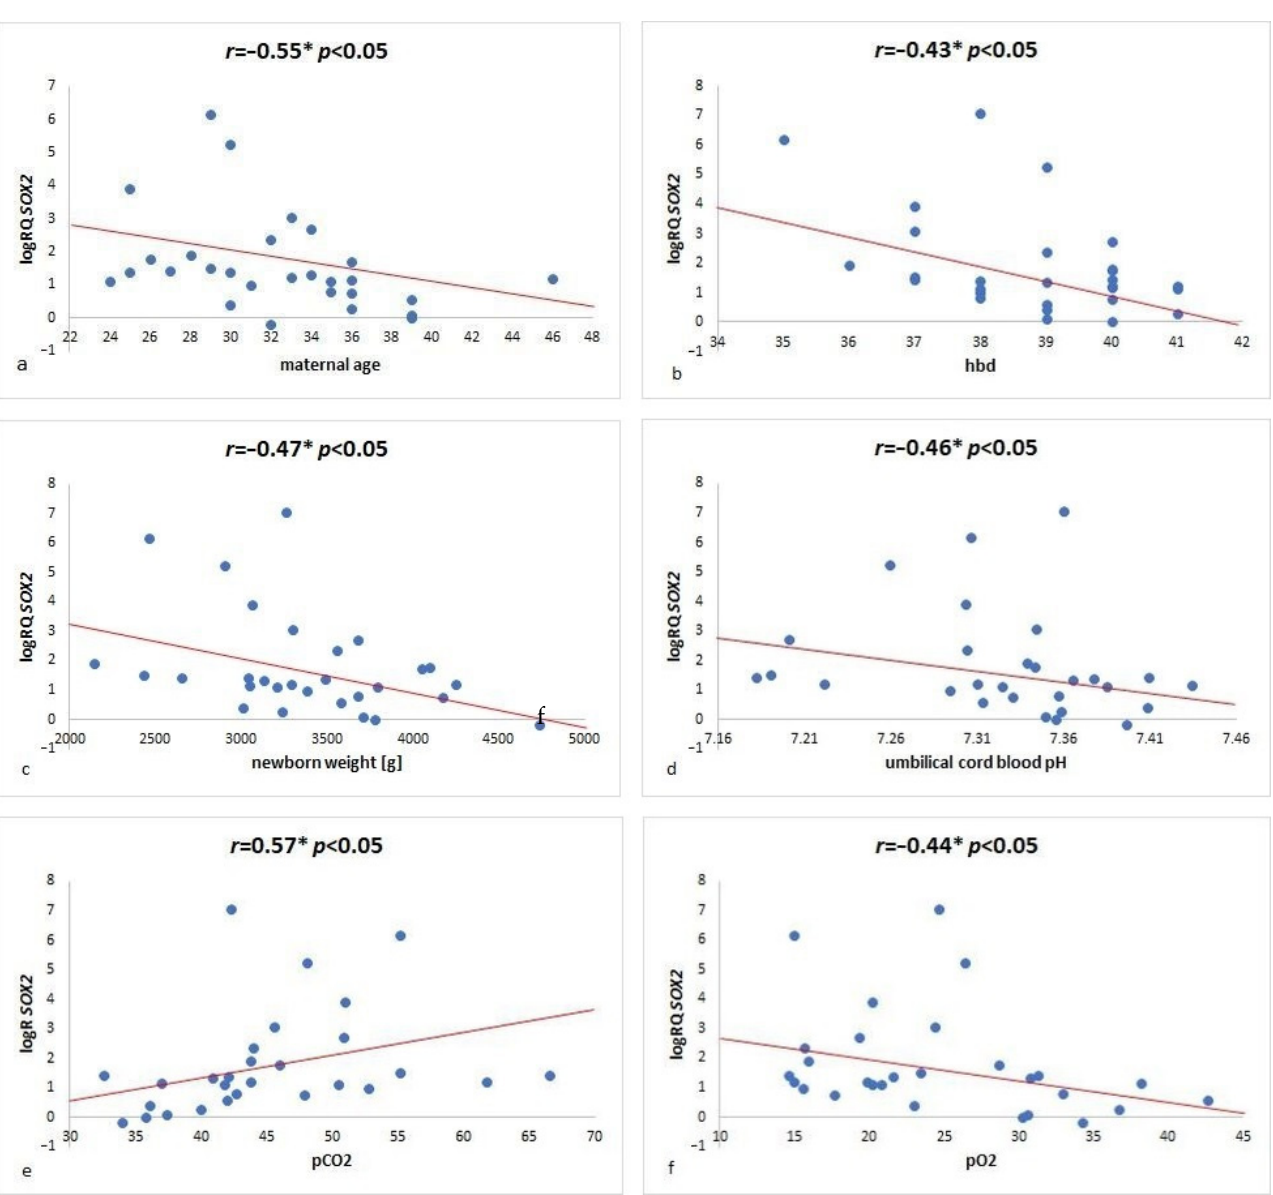
Figure 5. SOX2 gene expression (logRQ) on ( a ) the parturient’s age ( b ) the week of pregnancy in which the birth took place, ( c ) newborn’s birth weight, ( d ) pH of the umbilical cord blood, ( e ) carbon dioxide pressure, ( f ) oxygen pressure. * The Spearman Rank Order.